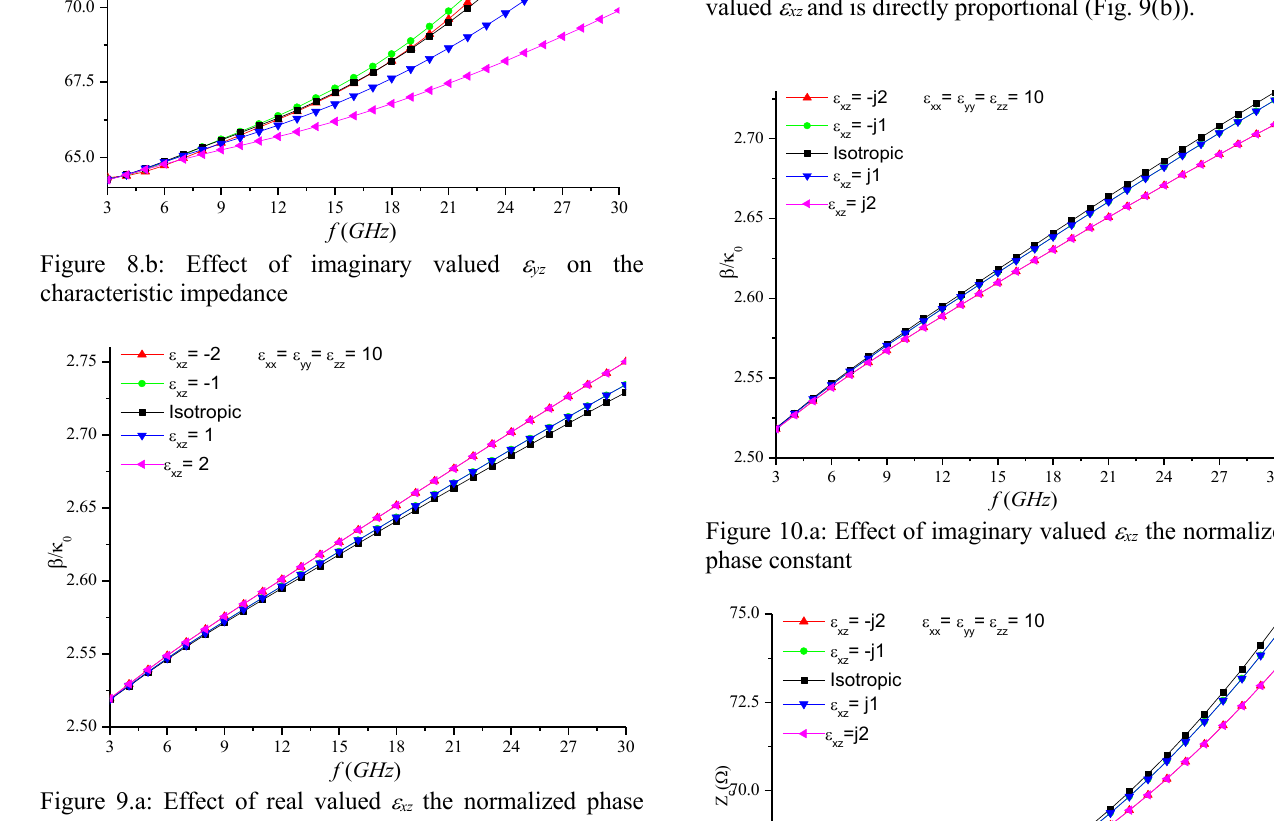
the normalized phase xz